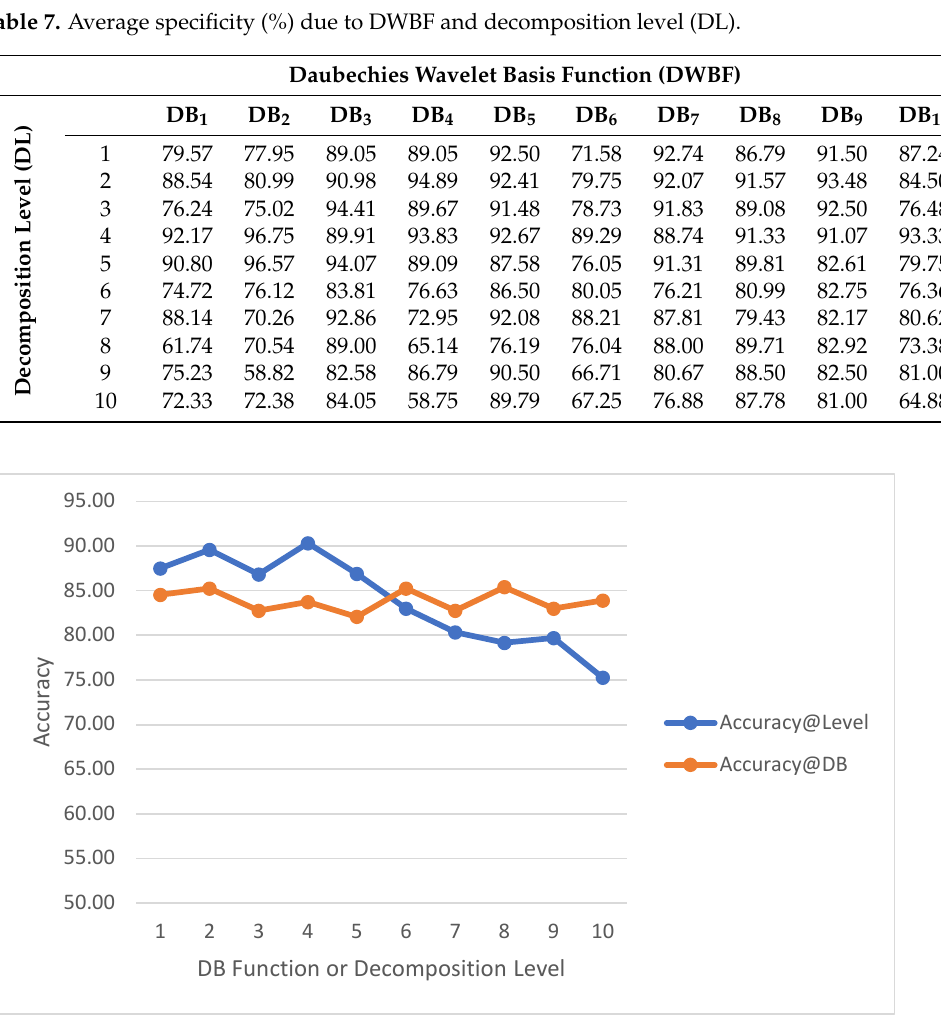
Figure 8. Accuracy due to DWBF and DL.